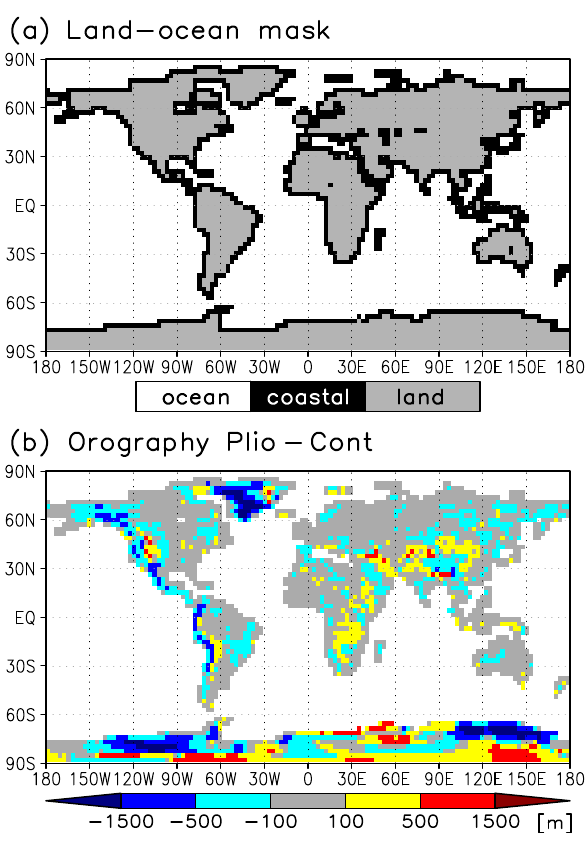
Fig. 1. Boundary conditions used in AGCM and AOGCM. (a) Land-ocean mask, (b) difference of orography (m) between Pliocene and Control.